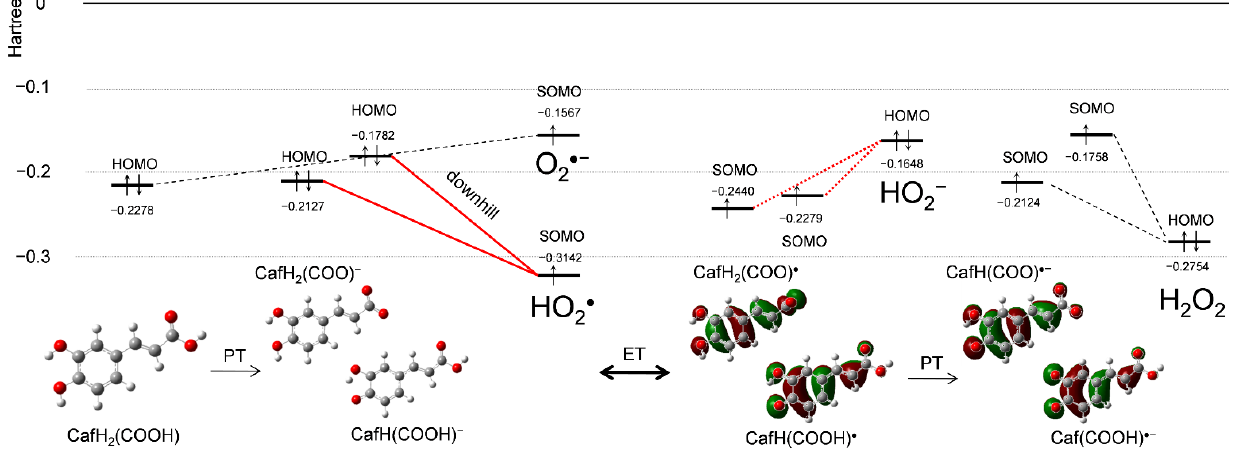
Figure 5. Changes in the HOMO − LUMO energies (Hartree/a.u.) along PCET mechanism